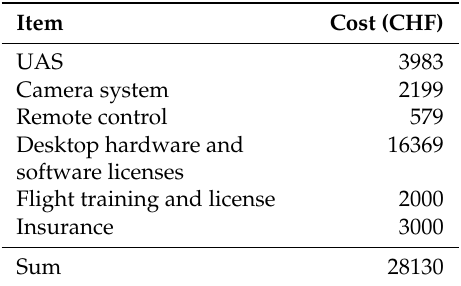
Table 6. UAS investment